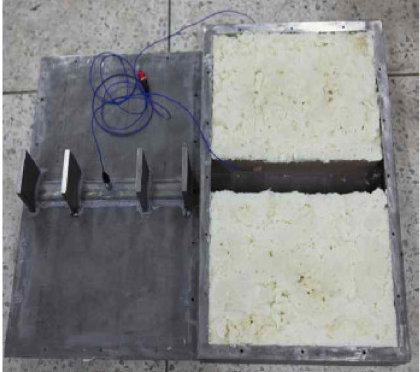
Figure 7. Urethane foam internal filling for noise proofing.